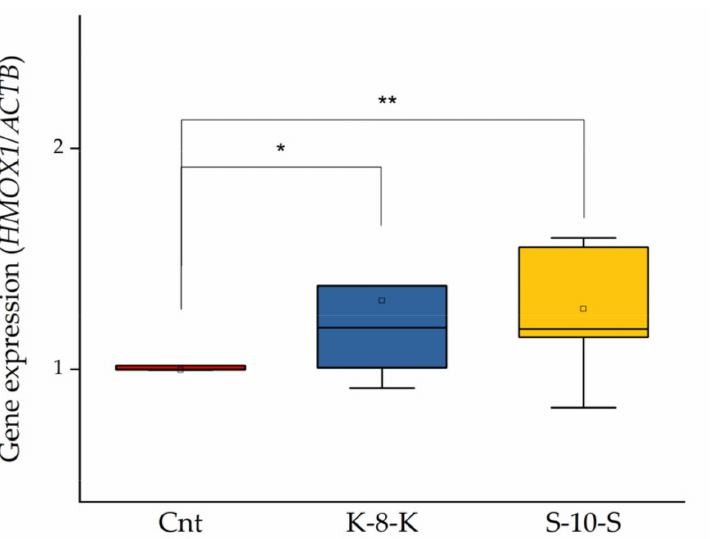
Figure 2. mRNA expression analysis of HMOX1 . Caco-2 cells were treated with 0.05 mg/mL K-8-K and S-10-S for 24 h, and then mRNA was purified as described in Section 4. qRT-PCR analysis of HMOX1 expression was performed to estimate its potential overexpression. β -Actin ( ACTB ) was used as a reference. Means of at least three replicates estimated in duplicate were compared (** p < 0.01, * p < 0.05). Cnt: untreated